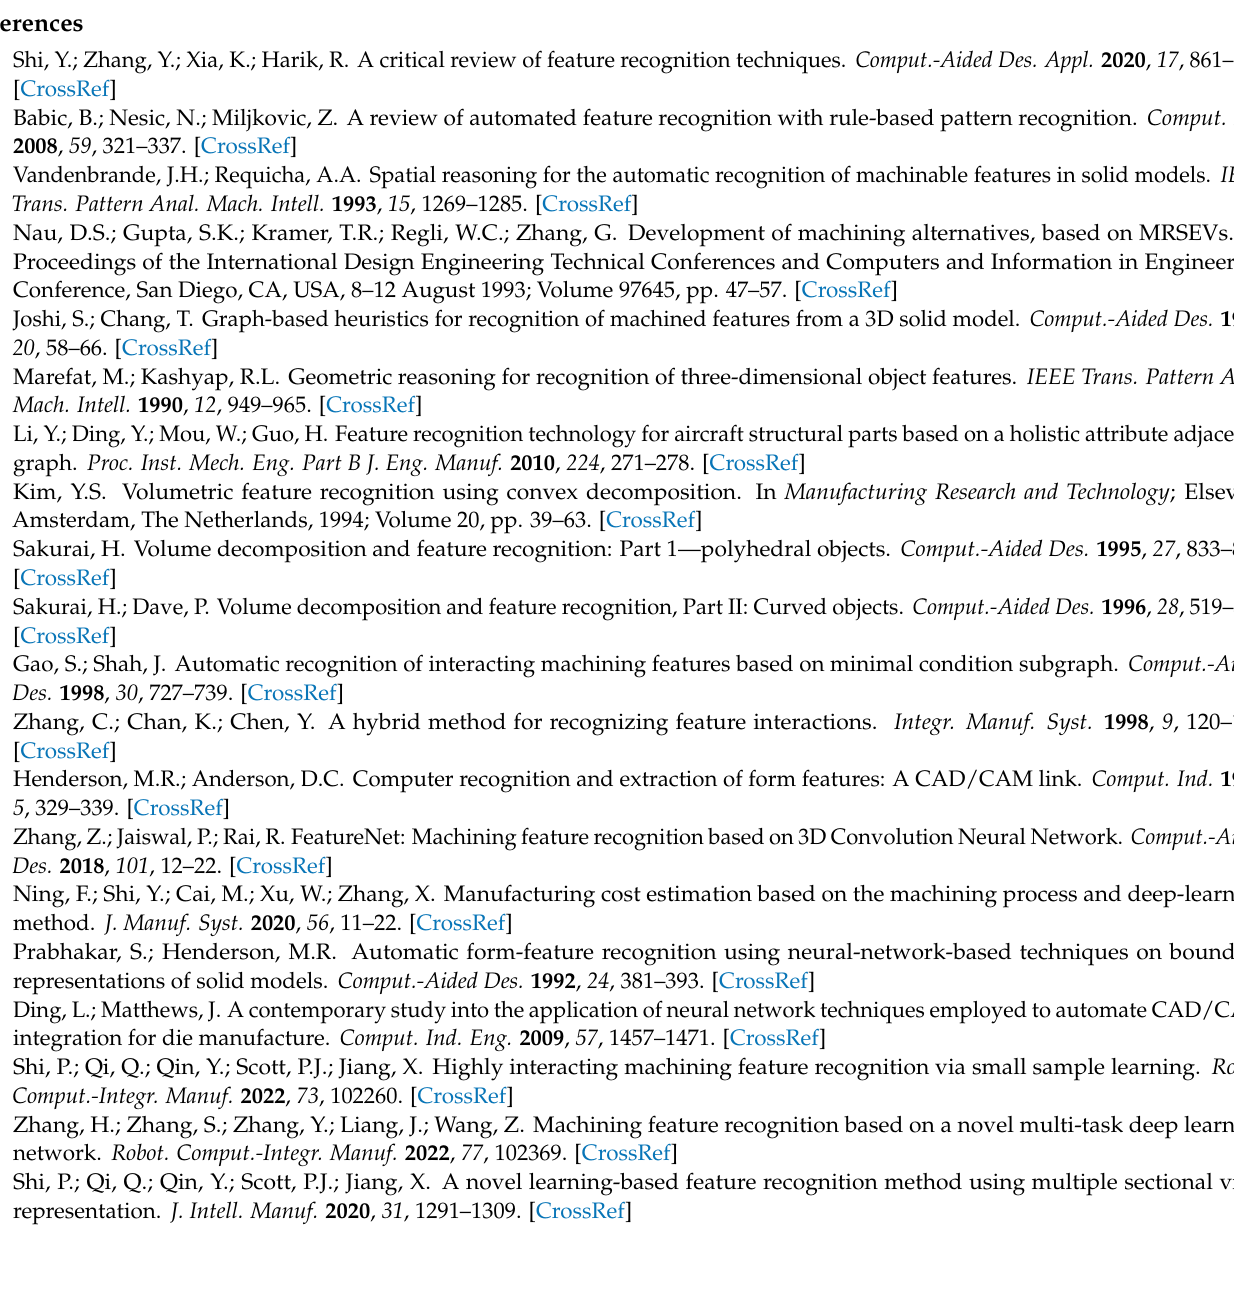
curve (AUC = 1.00) for class Triangular through slotROC curve (AUC = 0.99) for class Rectangular through slotROC curve (AUC = 0.99) for class Rectangular blind slotROC curve (AUC = 1.00) for class Triangular pocketROC curve (AUC = 0.99) for class Rectangular pocketROC curve (AUC = 0.99) for class Circular end pocketROC curve (AUC = 0.98) for class Triangular blind stepROC curve (AUC = 0.98) for class Circular blind stepROC curve (AUC = 1.00) for class Rectangular blind stepROC curve (AUC = 0.99) for class Rectangular through stepROC curve (AUC = 0.99) for class 2-sides through stepROC curve (AUC = 0.99) for class Slanted through stepROC curve (AUC = 0.98) for class ChamferROC curve (AUC = 0.98) for class RoundROC curve (AUC = 1.00) for class Vertical circular end blind slotROC curve (AUC = 1.00) for class Horizontal circular end blind slotROC curve (AUC = 0.97) for class 6-sides passageROC curve (AUC = 0.98) for class 6-sides pocket